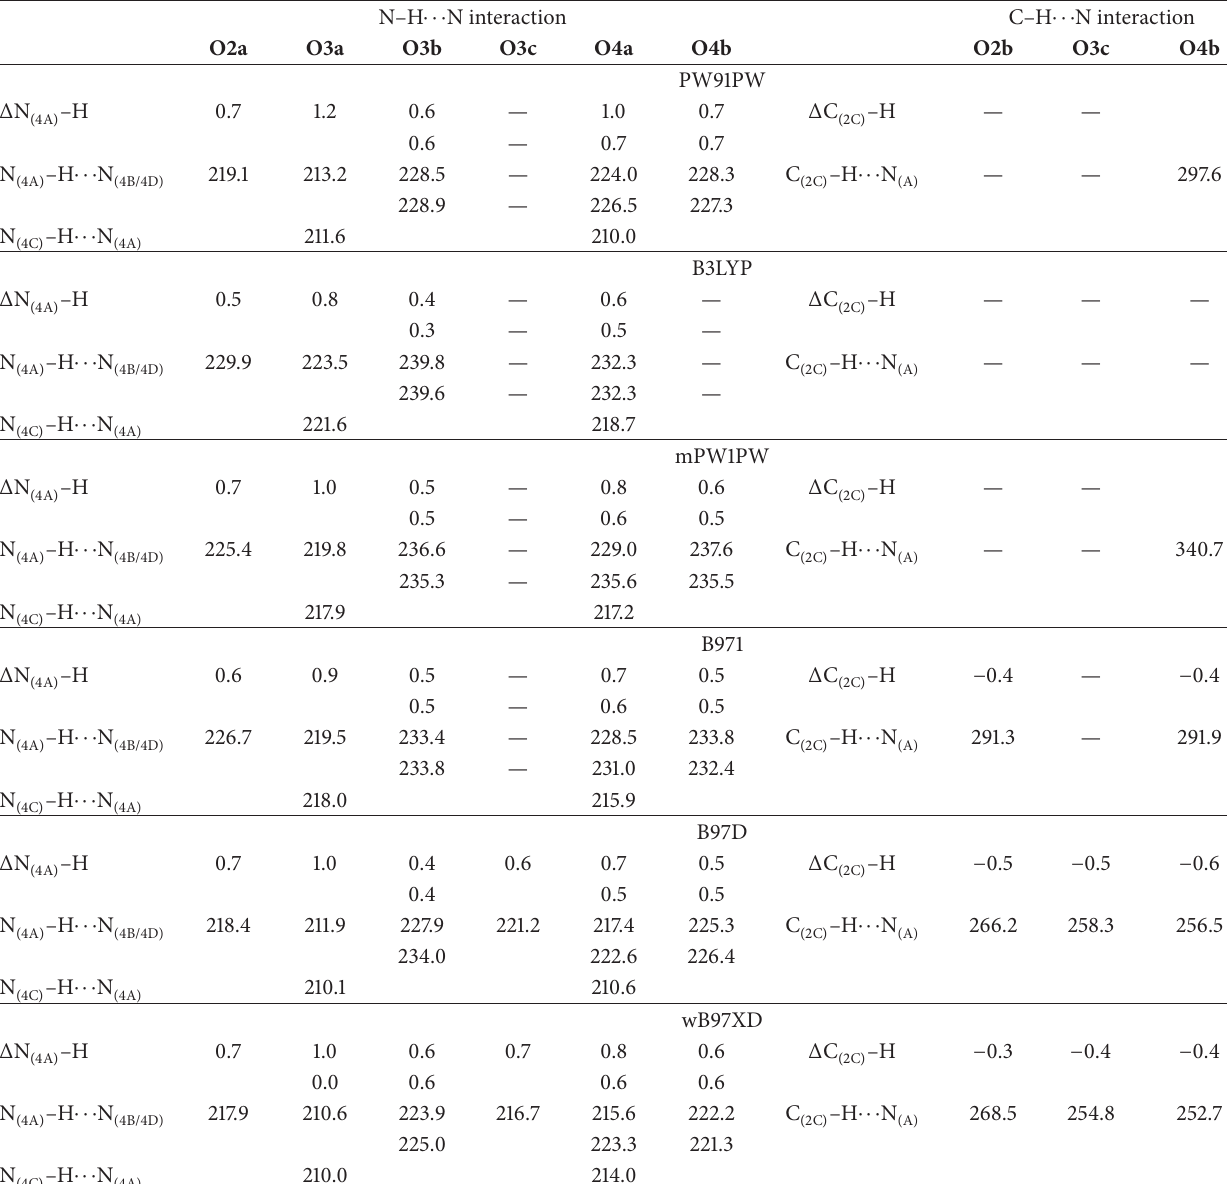
Table 1: Selected CP-corrected N–H and C–H distance variations and H ⋅⋅⋅ N distances, in pm, calculated for each molecular cluster, as a function of oligomer type and DFT. Atom and cluster nomenclature according to Figure